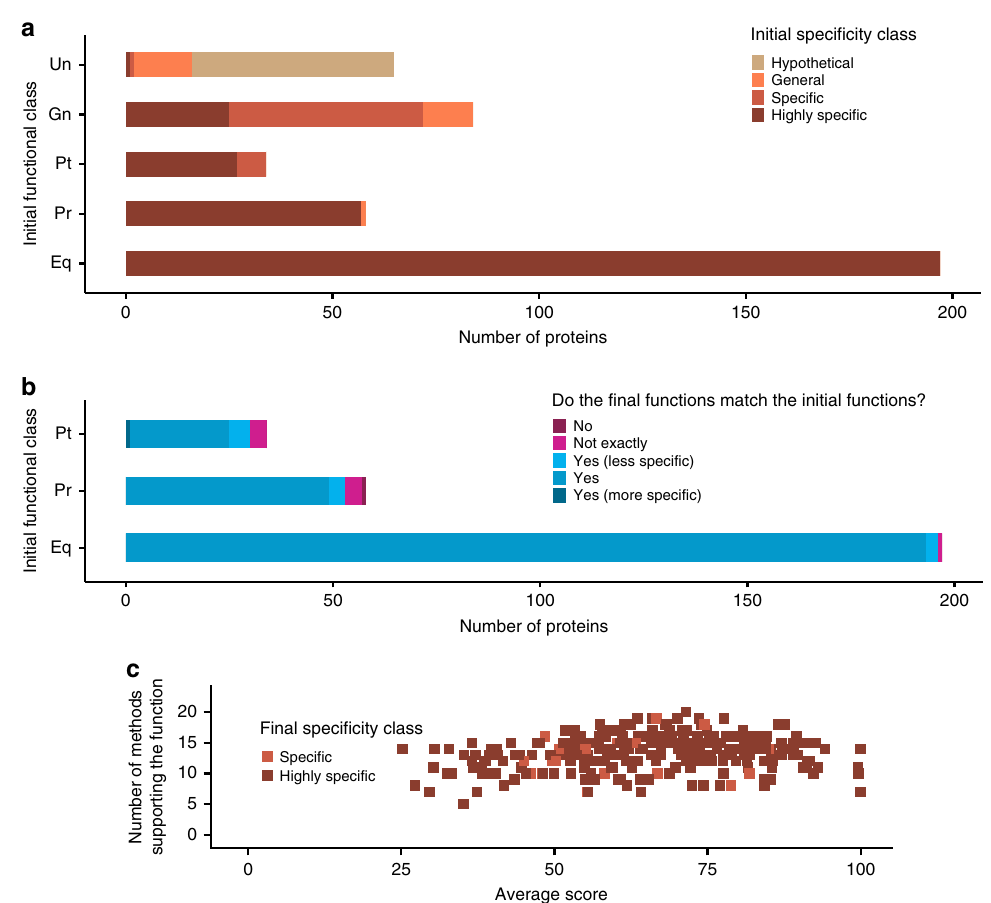
Fig. 3 Predictions for proteins of known function encoded by the minimal genome. a Assessment of the speci fi city of functions predicted by Hutchison et al. across all fi ve initial functional classes (Unknown to Equivalog). Functions from different initial speci fi city classes are represented by a different colour: beige for the Hypothetical speci fi city class, orange – General, light brown – Speci fi c and dark brown – Highly speci fi c. b Comparison of our predictions with the functions predicted by Hutchison et al. for proteins of known function, i.e., from the Putative, Probable and Equivalog functional classes. Colouring indicates the level of agreement between the initial functions and the predictions made here. Dark blue where the functions exactly match, medium blue where the predictions made here were less speci fi c than the initial ones, light blue where our predictions were more speci fi c, dark purple where there were minor differences between the functions and light purple where the function did not agree. c Number of methods supporting the function and the average score of those methods. Each point represents a protein. Methods include those used in the fi rst step of function prediction. Speci fi city class colouring as for